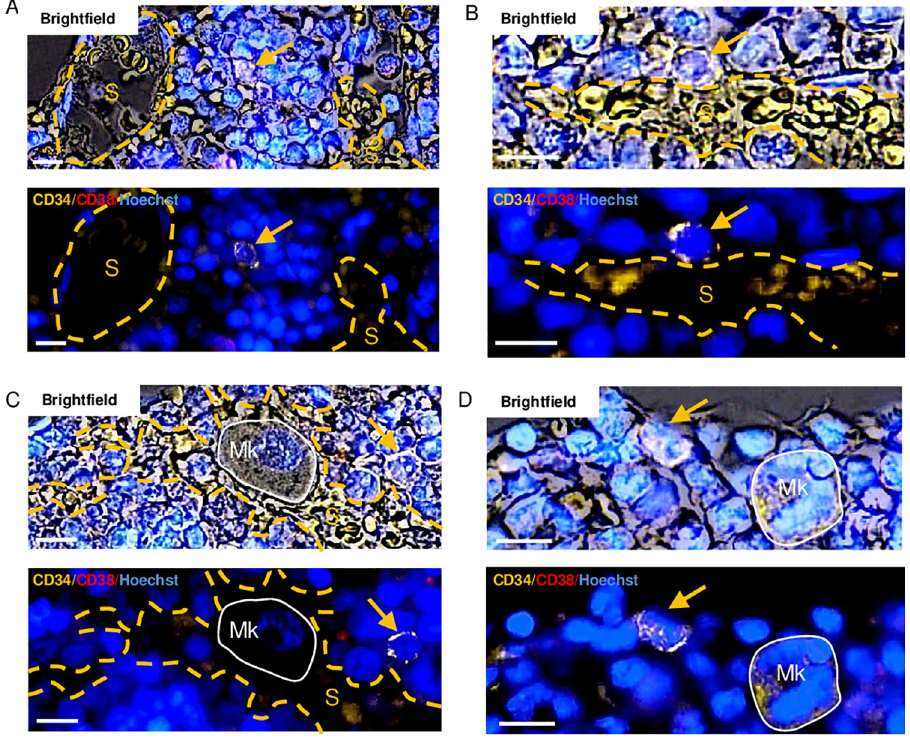
Fig 4. Illustrations of HSCs/MPPs that are positioned within a distance of 30 μ m from sinusoids and/or megakaryocytes. The representative images are obtained from four different biopsies that were multiplex-stained as indicated. They are shown in brightfield (upper images) and pure fluorescence (lower images). (A) Presence of two different sinusoids (S and dashed yellow lines) within a distance of 30 μ m from an HSC/MPP (yellow arrow). (B) Contact between a sinusoid and an HSC/MPP. (C) Presence of both a sinusoid and a megakaryocyte (Mk and white solid line) within a distance of 30 μ m from an HSC/MPP. (D) Presence of a megakaryocyte within a distance of 30 μ m from an HSC/MPP. Scale bars = 10 μ